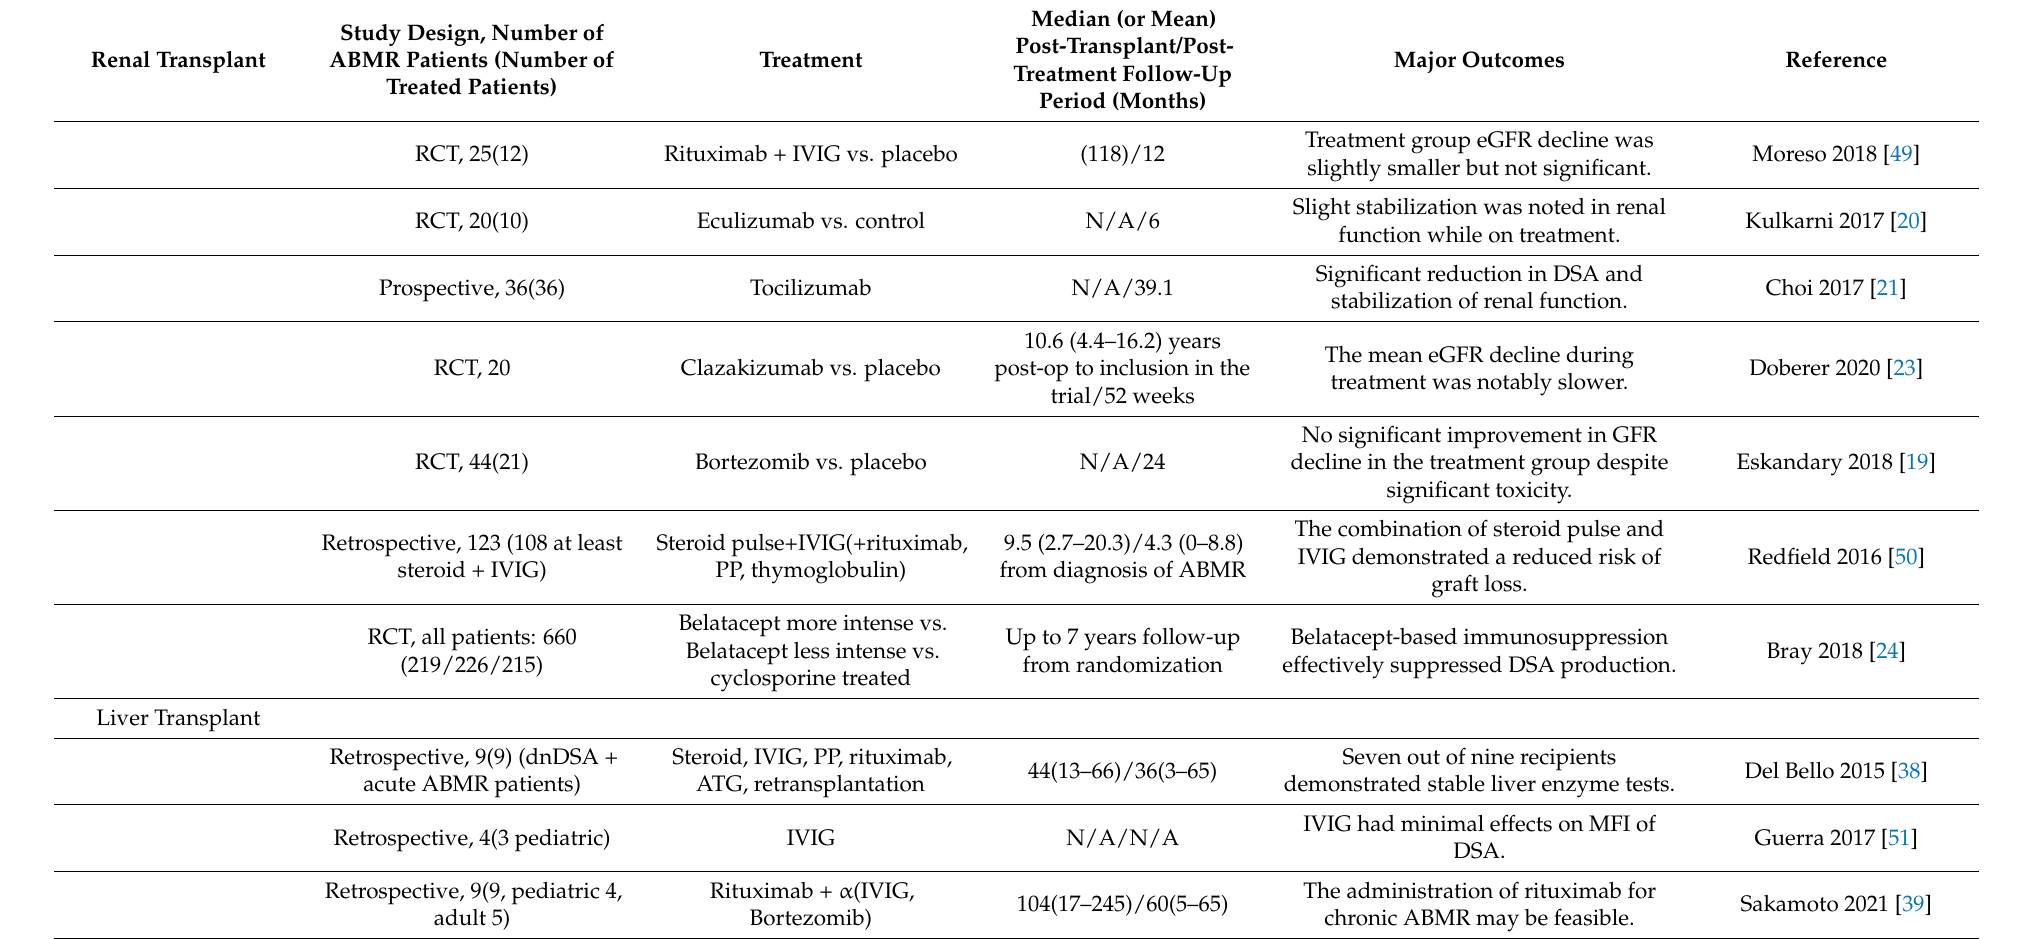
Table 1. Summary of recent studies in chronic ABMR due to